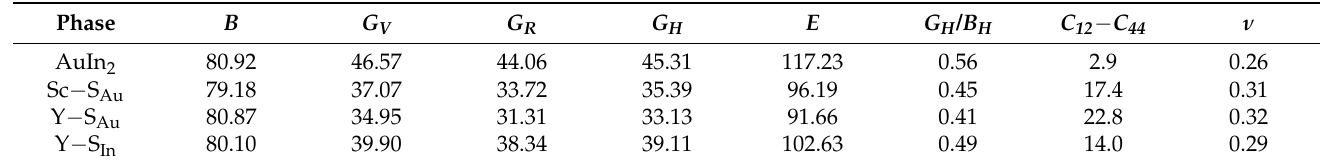
Table 3. The calculated bulk modulus B (in Gpa), shear modulus G (in Gpa), Young’s modulus E (in Gpa), Cauchy pressure C 12 − C 44 (in Gpa), G/B ratio, and Poisson’s ratio ν of AuIn 2 and doped